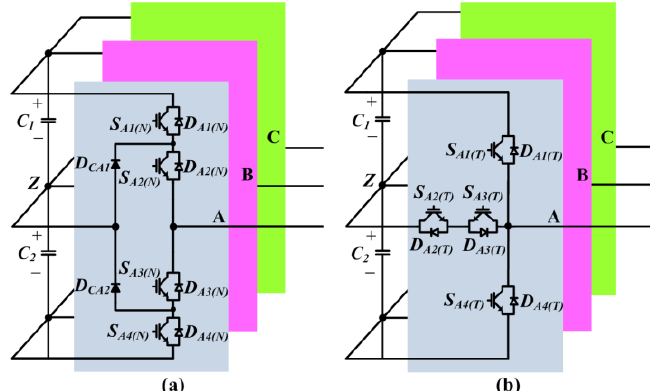
Figure 2. Simplified circuit diagrams of three-level inverters: ( a ) neutral-point clamped (NPC) inverter; ( b ) T-type inverter.